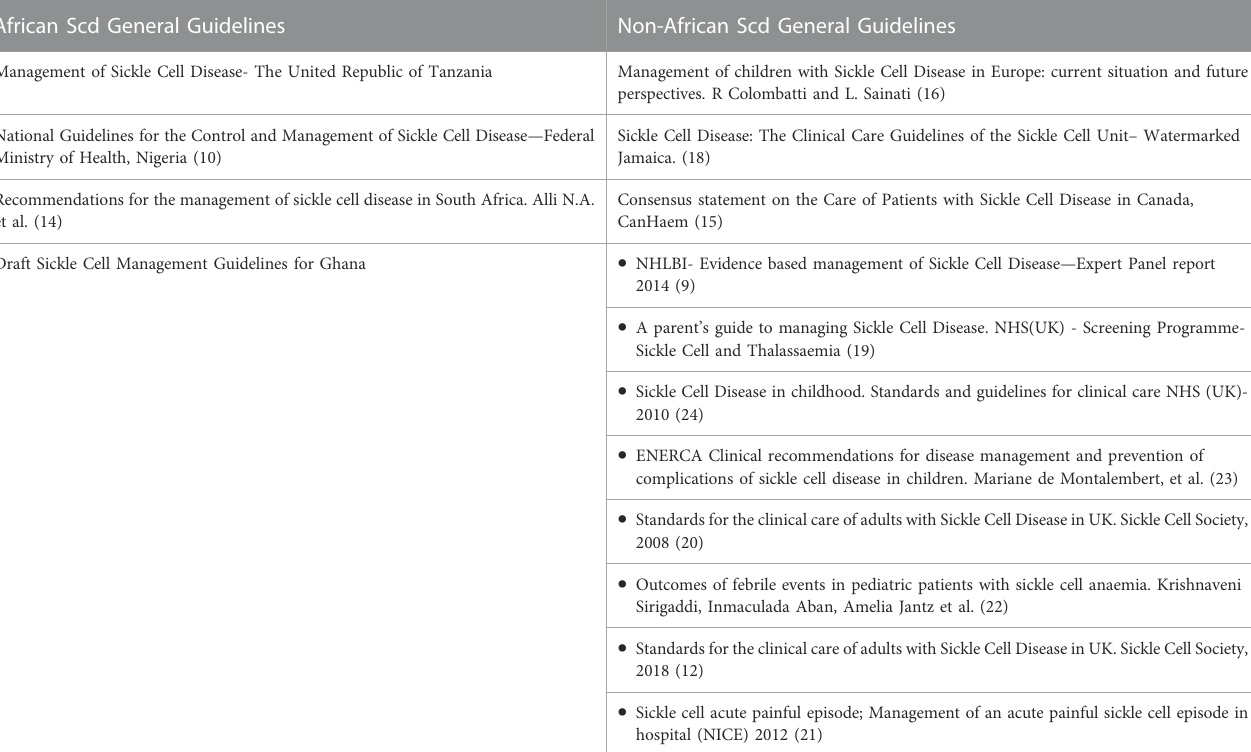
TABLE 3 Existing guidelines reviewed by the SoC working group. African Scd General Guidelines Non-African Scd General